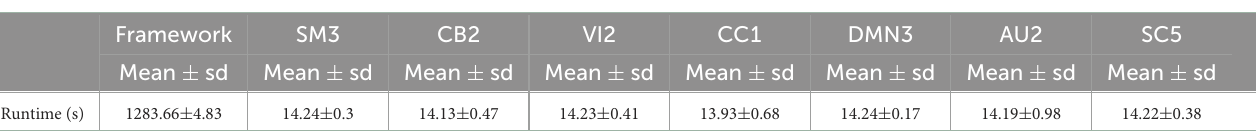
TABLE 3 Time complexity of the